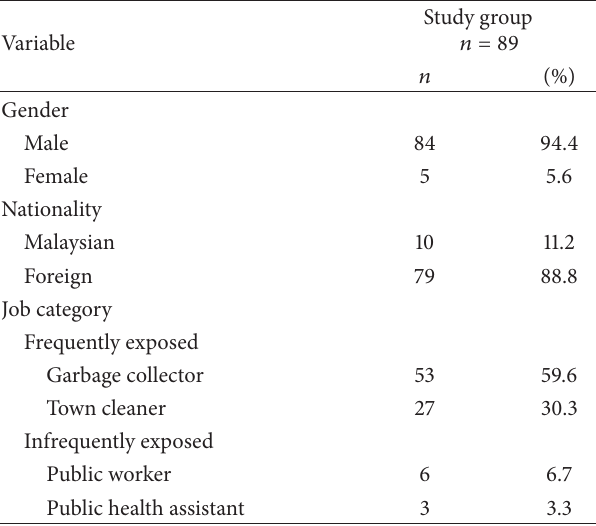
Table 3: Prevalence of leptospiral antibodies according to job category.